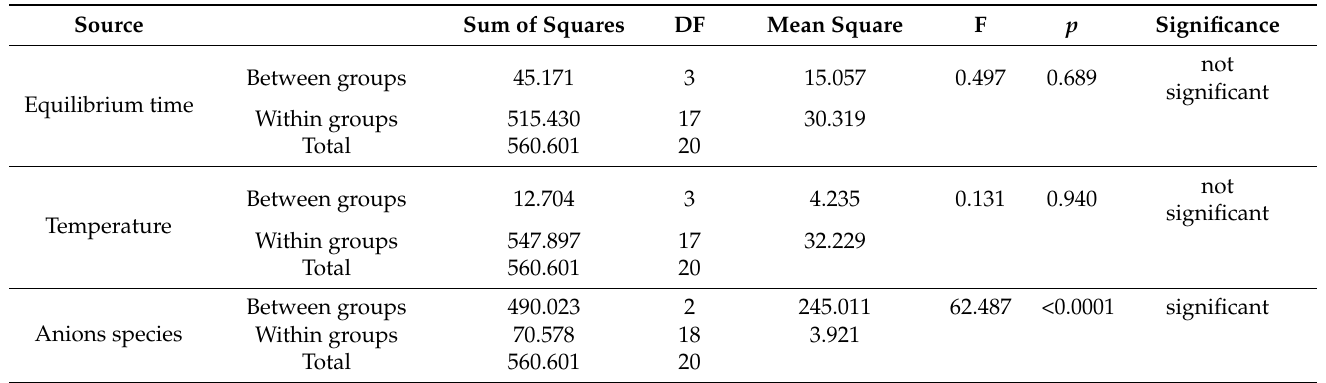
Table 5. ANOVA results of the experimental